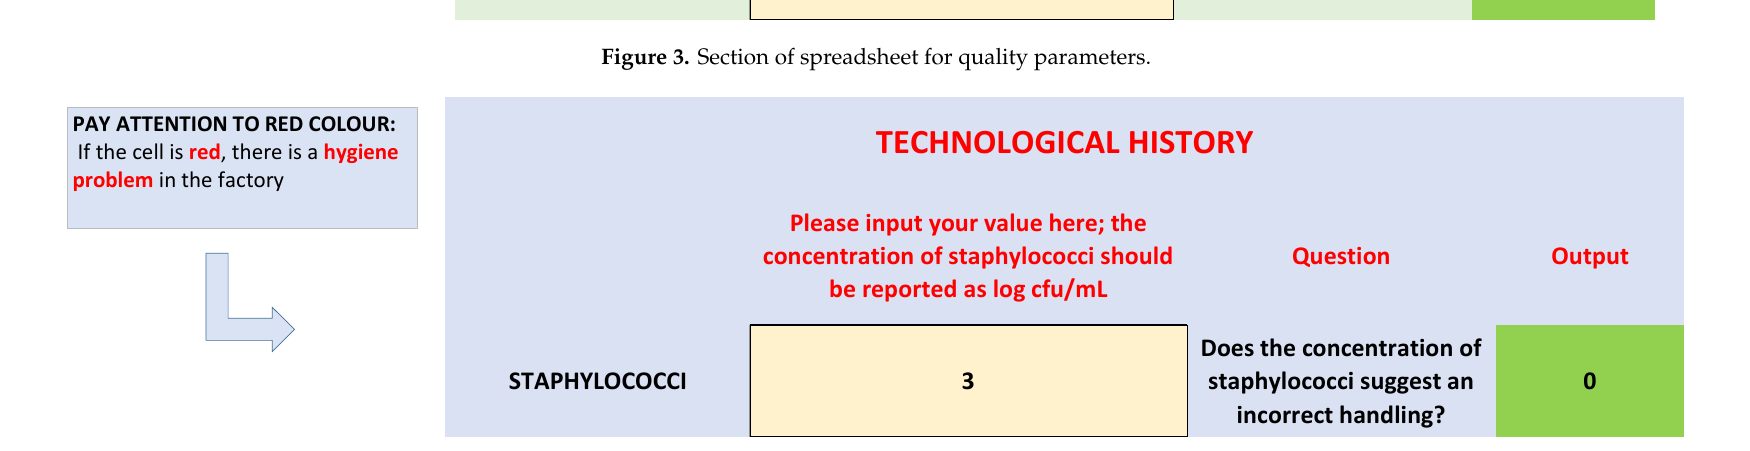
Figure 4. Section of spreadsheet on technological history.